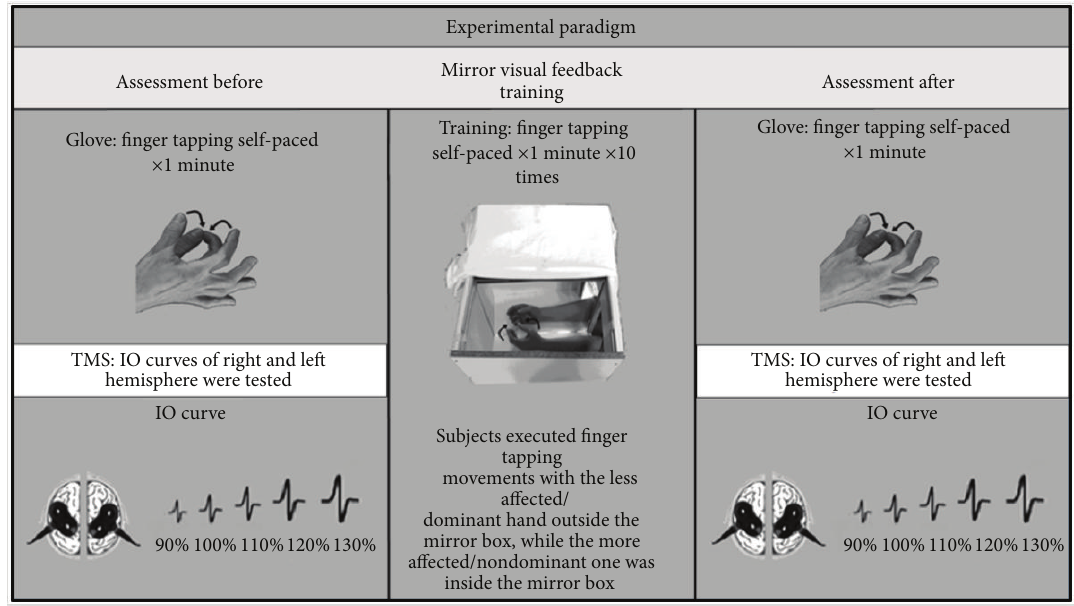
Figure 1: Experimental paradigm.